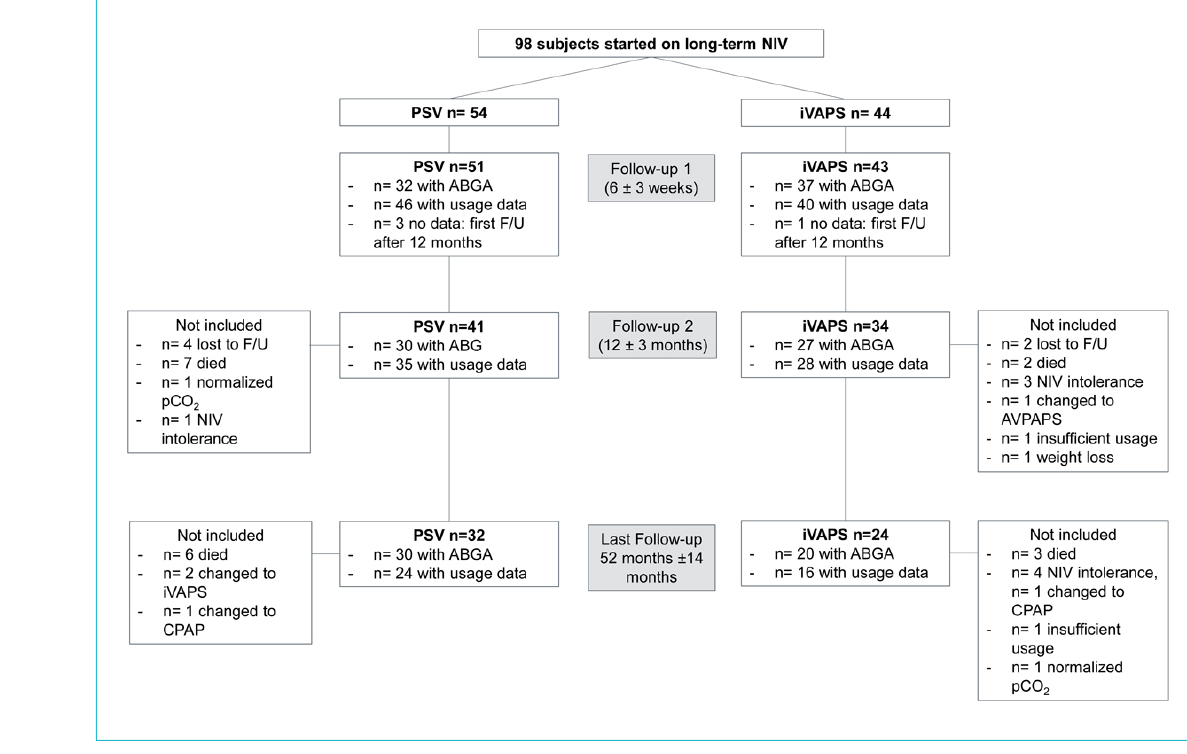
Figure 1: Patient flow chart. ABGA = arterial blood gas analysis; AVAPS = average volume assured pressure support; CPAP = continuous positive airway pressure; F/U = follow-up; iVAPS = intelligent volume assured pressure support; NIV = noninvasive ventilation; PSV = pressure support